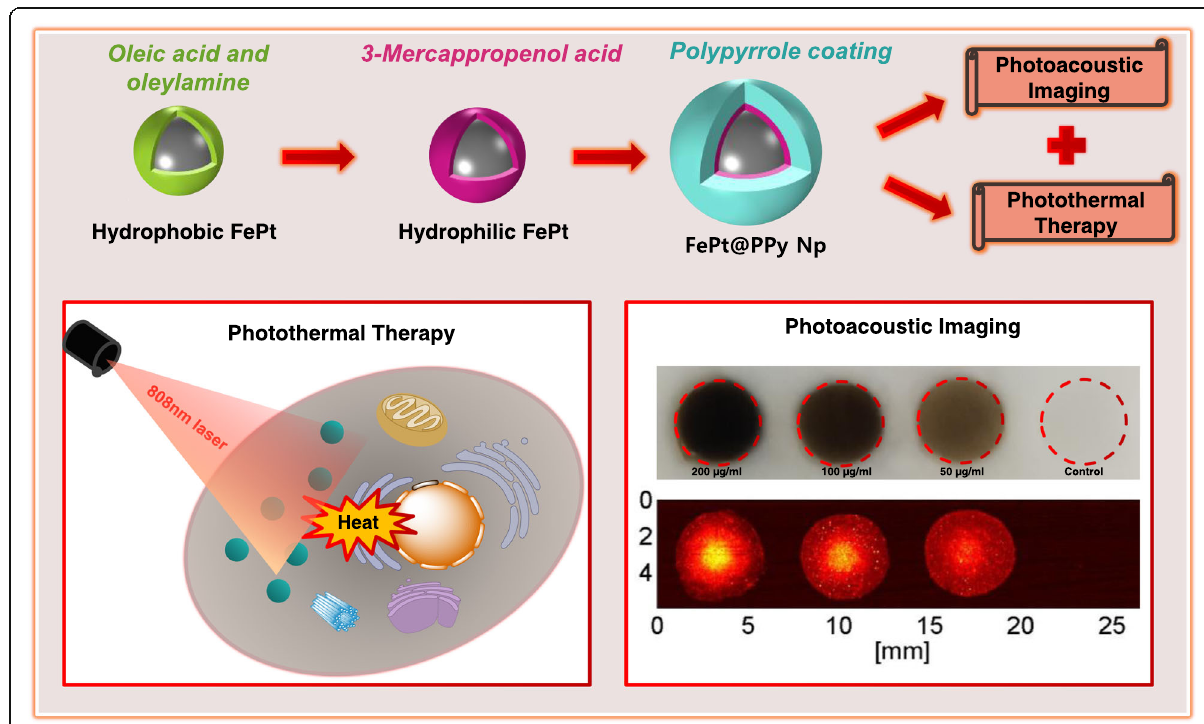
Fig. 4a, with an increase of FePt@PPy NP